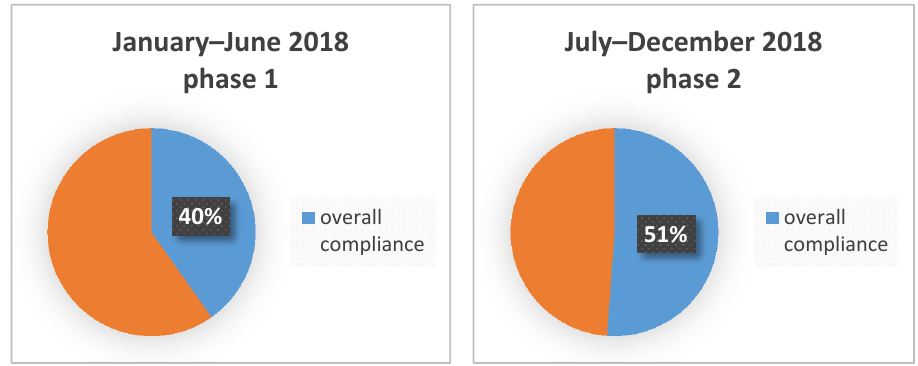
Figure 2. Overall compliance to SAP in phase 1 (January-June 2018) and phase 2 (July-December 2018).